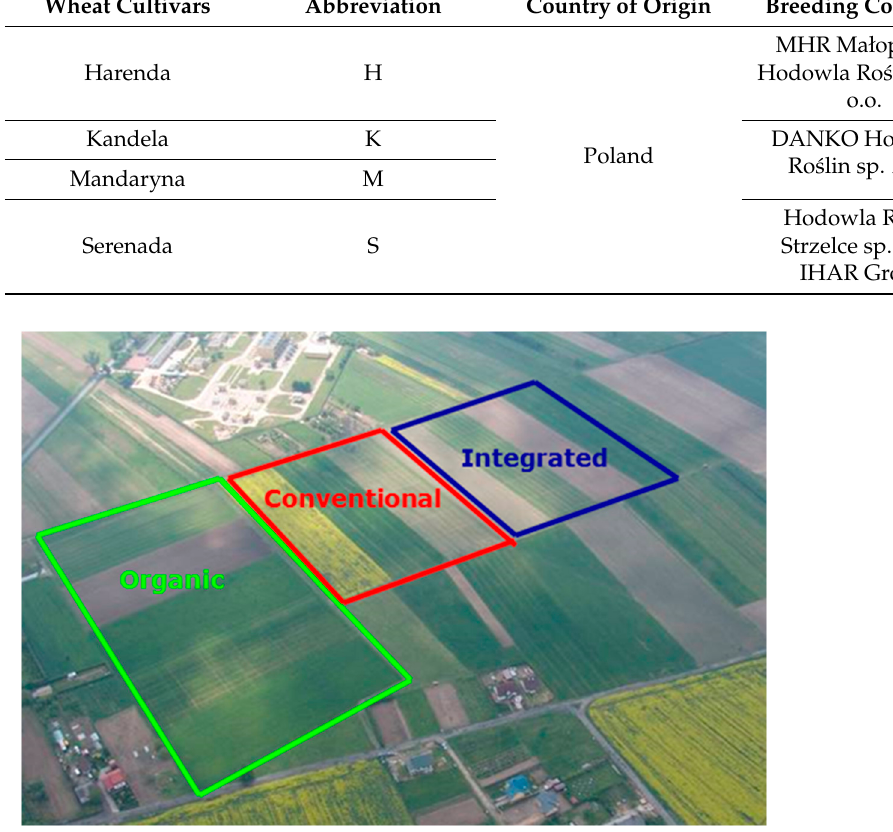
Figure 6. Scheme of the Osiny experimental field with a breakdown of the different farming sys- tems.